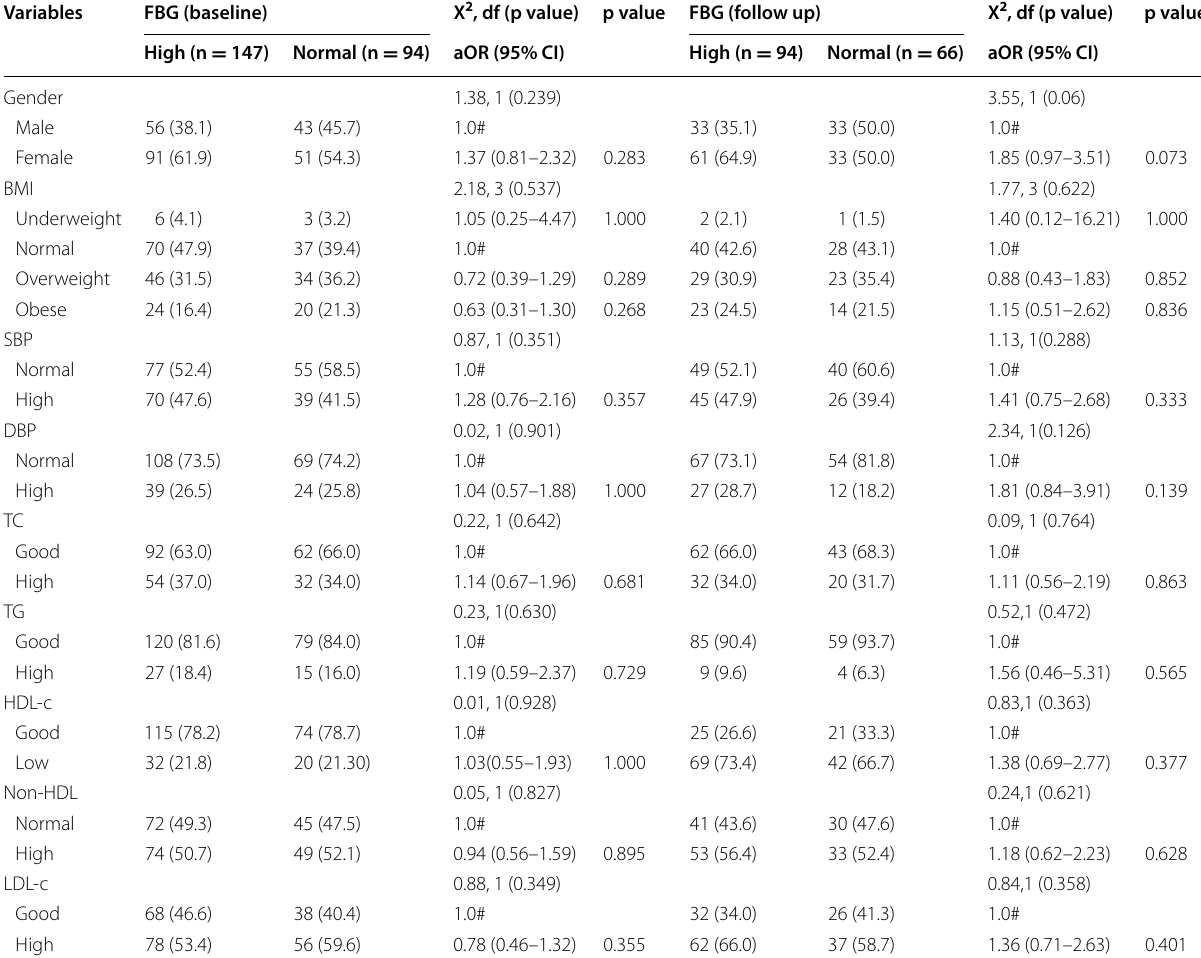
Table 3 Association between metabolic risk factors and FBG levels at baseline and follow up